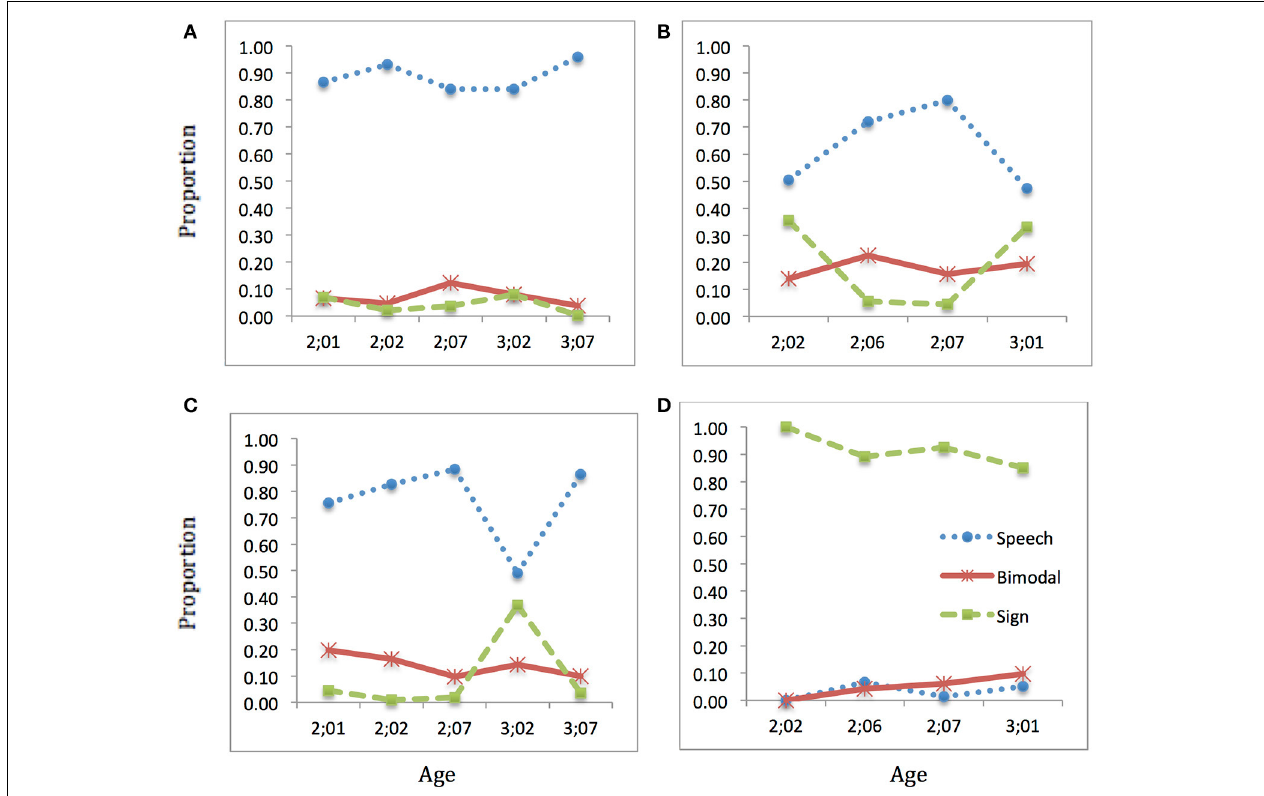
FIGURE 8 | Language choice over time: IGOR. Proportion of speech (blue dotted), sign (green dashed), and bimodal (red solid) utterances produced: (A) child speech target; (B) child sign target; (C) interlocutor(s) speech target; (D) interlocutor(s) sign target (Note: Intervals along x-axis are not